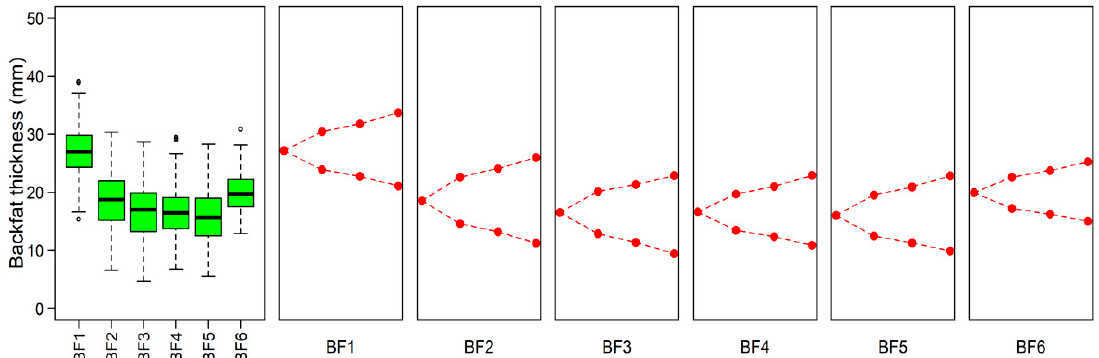
Figure 1. Descriptive statistics of six backfat thickness traits and the visualization of three phenotypic gradient differential population pairs for each trait. The left ‘box-and-whiskers’ plot describes the distribution of a continuous phenotypic variable. The other plots describe three phenotypic gradient differential population pairs for each trait. In order from left to right, the source Yorkshire population, the 1st population pair, the 2nd population pair and the 3rd population pair are stretched along each drawing area, and the phenotypic differentiation is gradually increased. BF1: Shoulder subcutaneous fat thickness; BF2: backfat between 6th and 7th thoracic vertebras; BF3: backfat at 10th rib; BF4: backfat at thoracolumbar junction; BF5: backfat at waist recommended vertebral junction; BF6: the average backfat thickness of shoulder subcutaneous fat thickness, backfat at thoracolumbar junction and backfat at waist recommended vertebral junction.